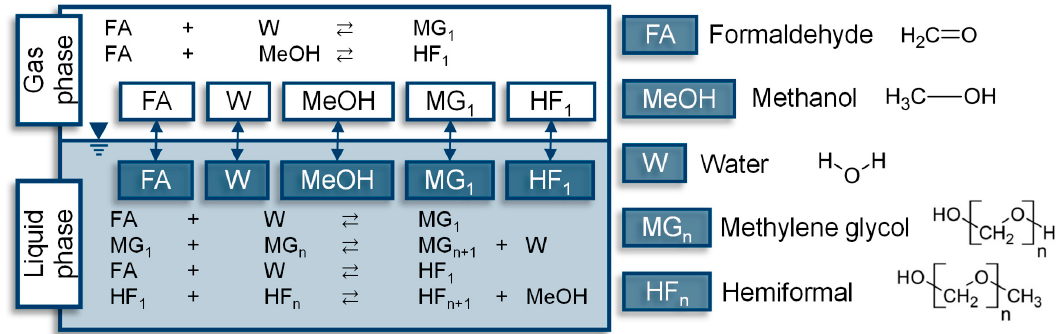
Figure 1. Chemical equilibrium reactions in water and methanol-containing formaldehyde (FA) solutions [30–35,37,39].